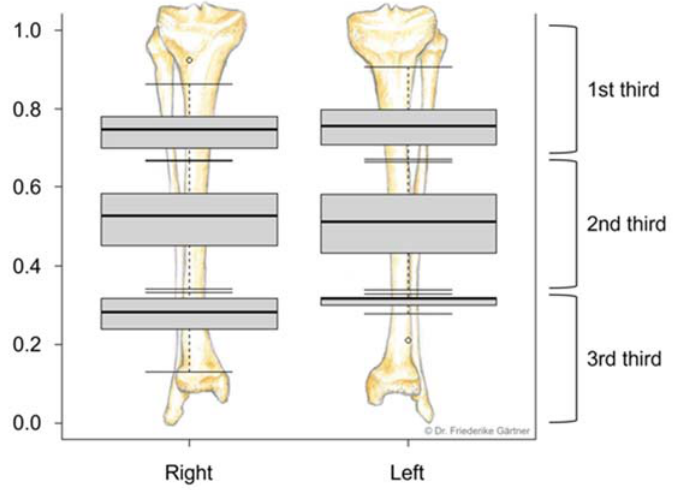
Figure 5. Normalized location of perforators in relation to the fibular length of an individual patient. Boxplots show the distribution of perforators relative to the 1st, 2nd, and 3rd third of the right and left fibula. This graph contains data from both radiologists. The small circle in the upper third of the right fibula and in the lower third of the left fibula indicates outlier values.